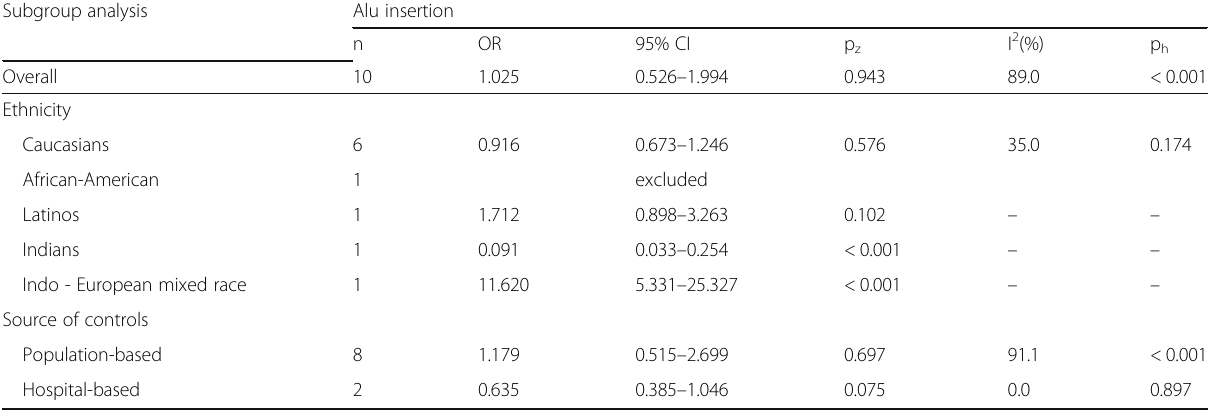
Table 4 Stratified analysis of the association of PGR polymorphism with breast cancer under dominant model Subgroup analysis